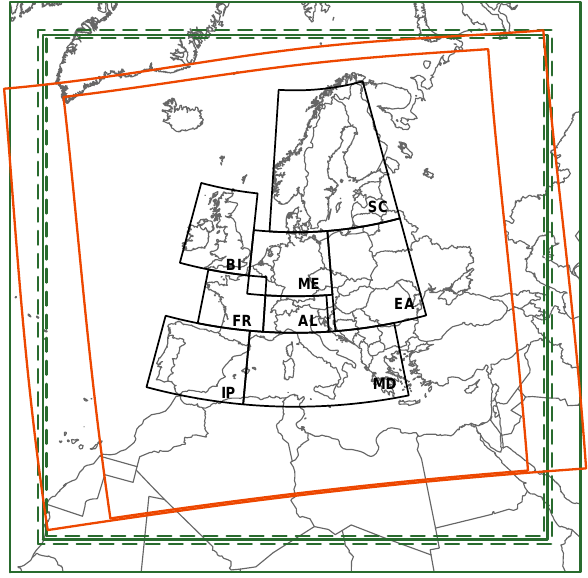
Figure 1. Domain boundaries of the used integration grids. The CORDEX community prescribes the rotated lat–long EURO- CORDEX domain (inner orange box) which is completely encom- passed by the E-OBS domain (outer orange box). The outer green boxes show the RMIB-UGent-11 (dashed lines) and RMIB-UGent- 44 (full lines) conformal Lambert domain boundaries. The inner green boxes exclude the eight grid point Davies coupling zone. In black the different European climatic regions as defined in Chris- tensen and Christensen (2007) are shown (BI: the British Isles, IP: the Iberian Peninsula, FR: France, SC: Scandinavia, ME: mid- Europe, AL: the Alps, MD: the Mediterranean, EA: eastern Eu-